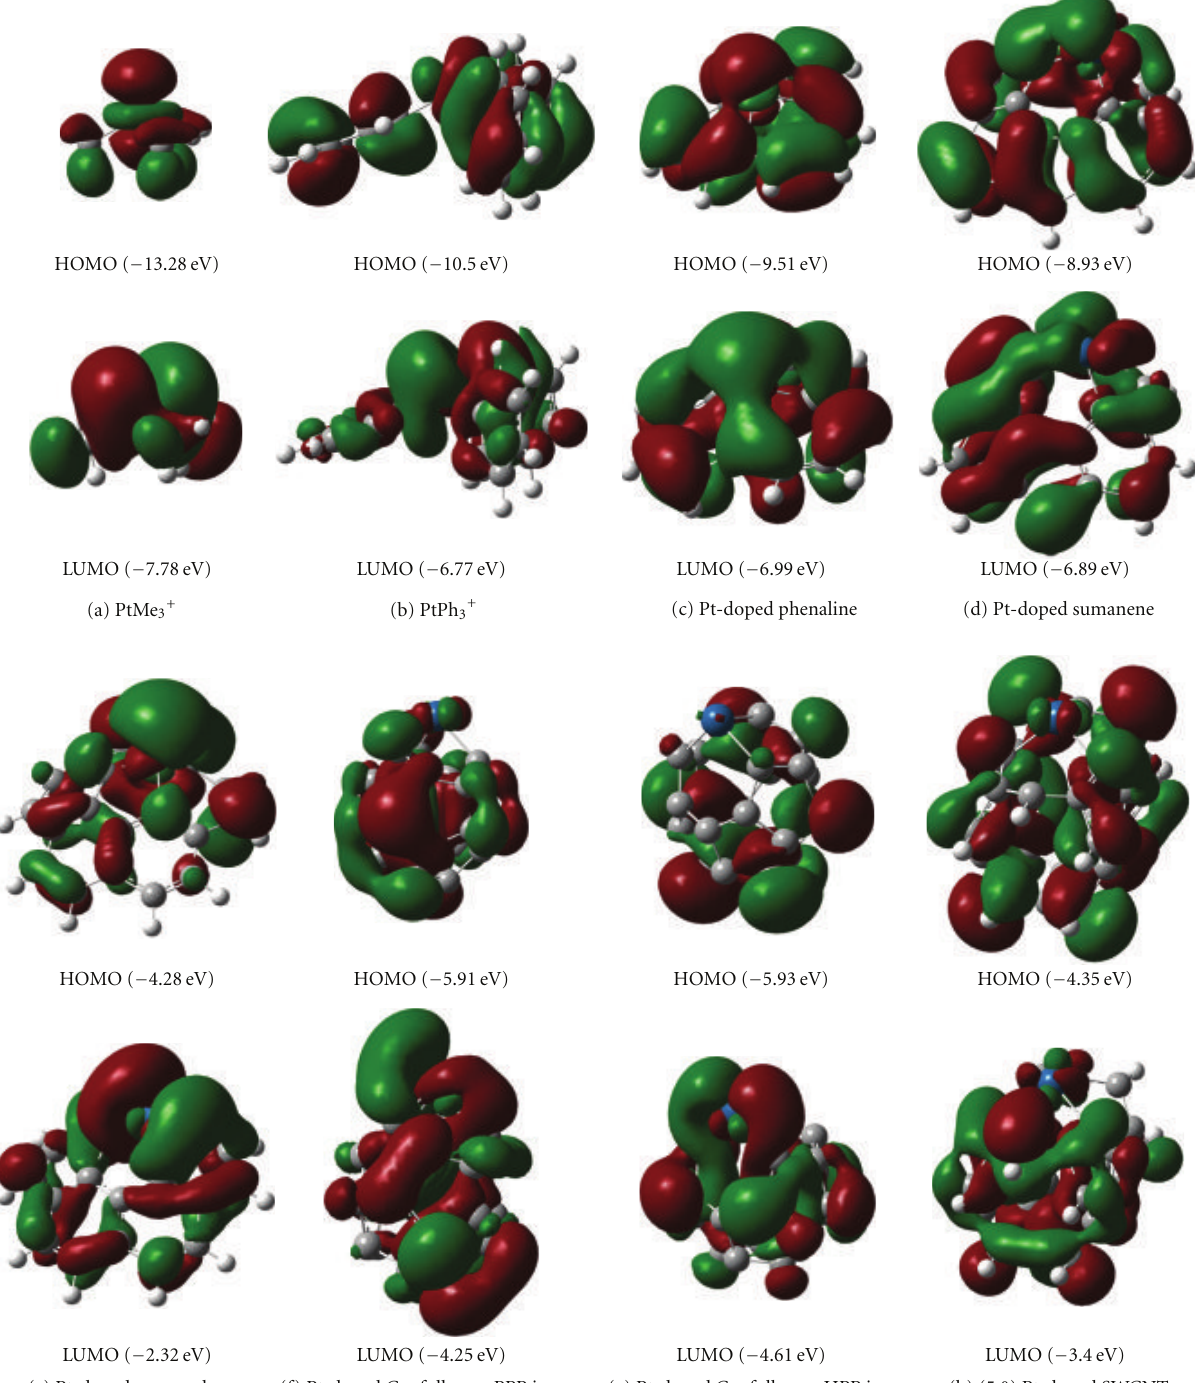
Figure 29: FMOs of model alkyl- and arylplatinum complexes, Pt-doped fullerene and SWCNT. Orbital energies are in parentheses [45].